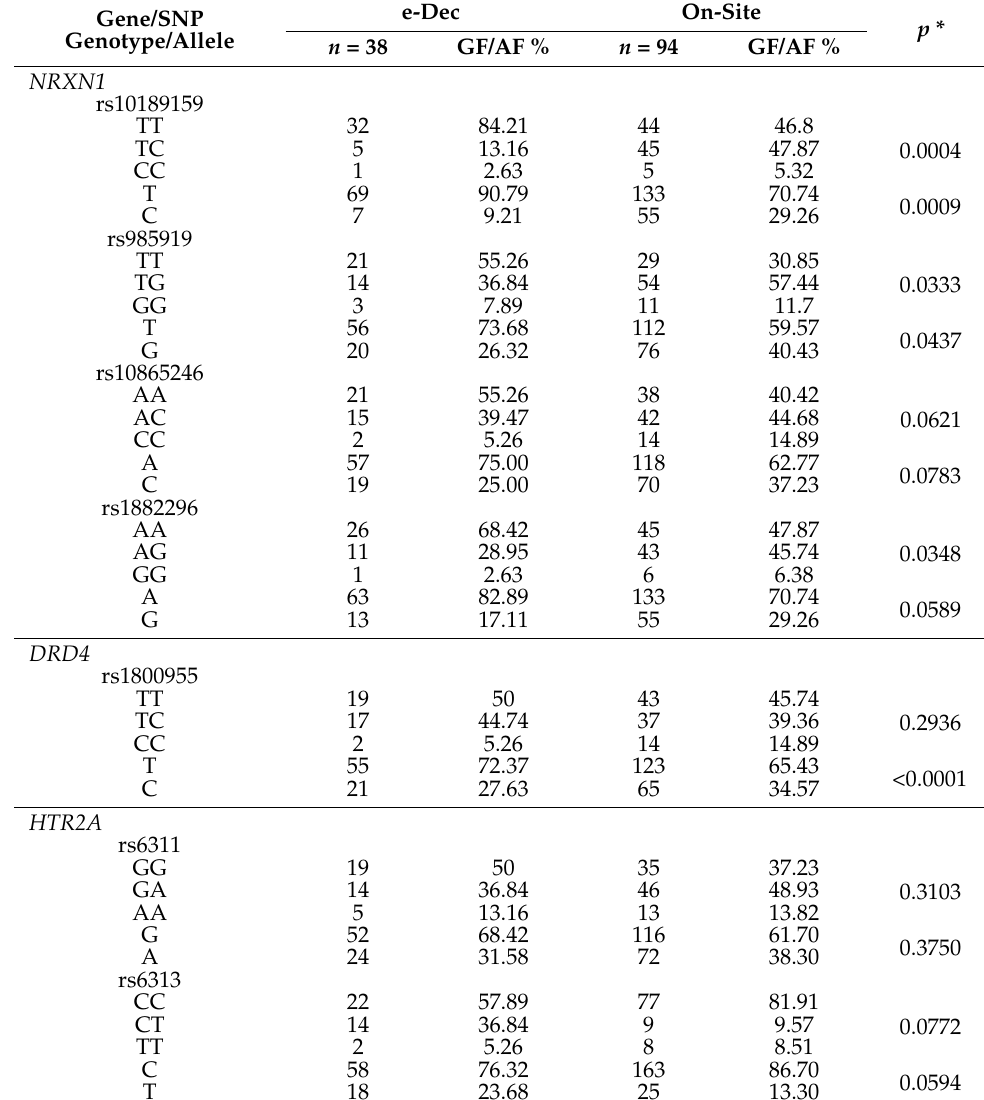
in groups where TT genotype frequency was higher in the e-Dec group (0.81 vs. 0.60) and both TC (0.35 vs. 0.15) and CC (0.04 vs. 0.02) genotypes were higher in the on-site group. Two SNPs in CHRNA5 had statistically significant differences in genotype frequencies, rs17408276 ( p = 0.0161) TT genotype frequency was higher in e-Dec group (0.81 vs. 0.56) and the heterozygous TC genotype was higher in the on-site group (0.41 vs. 0.15), minor allele CC genotype was similar in both groups (0.02 vs. 0.02); rs951266 ( p < 0.0001) had differences among genotype frequencies in groups where CC genotype frequency was higher in e-Dec group (0.94 vs. 0.54) and both CT (0.40 vs. 0.05) and TT (0.05 vs. 0.00) genotypes were higher in on-site group. Table 5. Genotype and allele frequencies in both groups included in this study in NRXN1 , DRD4 , HTR2A , CHRNA3 , CHRNA5 , and near CYP2A6 . Gene/SNP